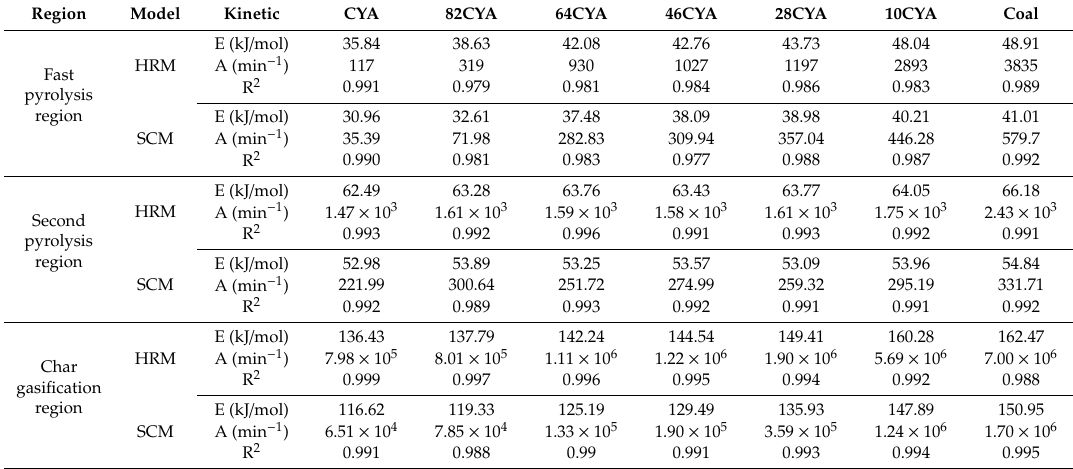
Table 3. Kinetic parameters of the chemical looping co-gasification of cyanobacteria and coal obtained from the homogeneous reaction model (HRM) and the shrinking core model (SCM).